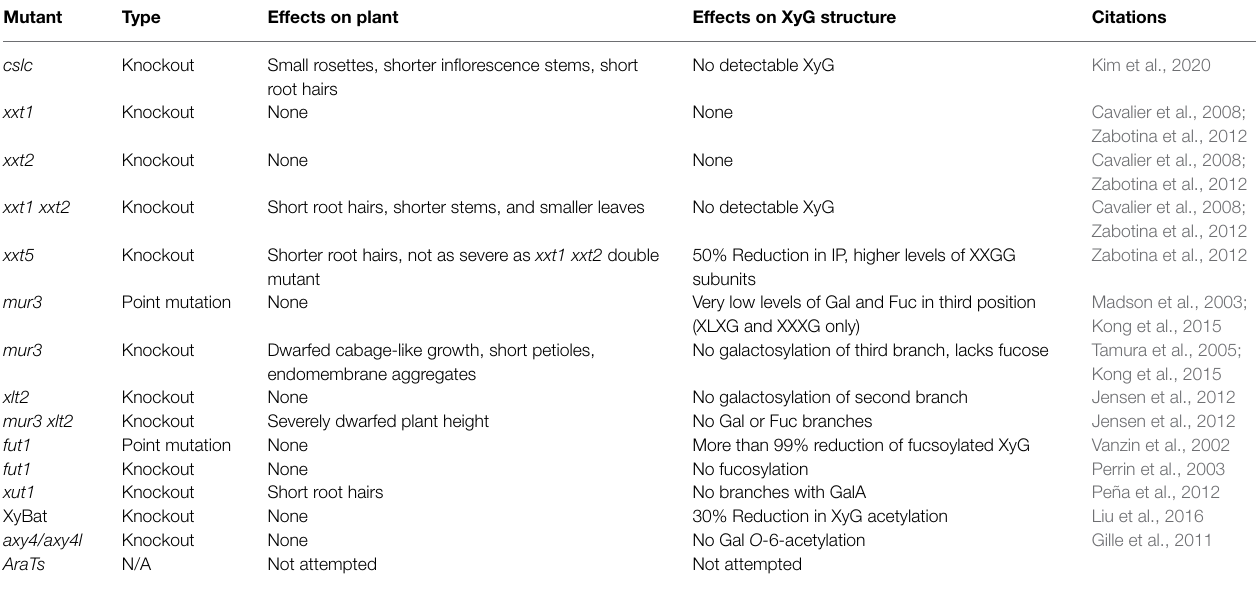
TABLE 1 | Summary of effects of XyG glycosyltransferases (GT) mutants in Arabidopsis .